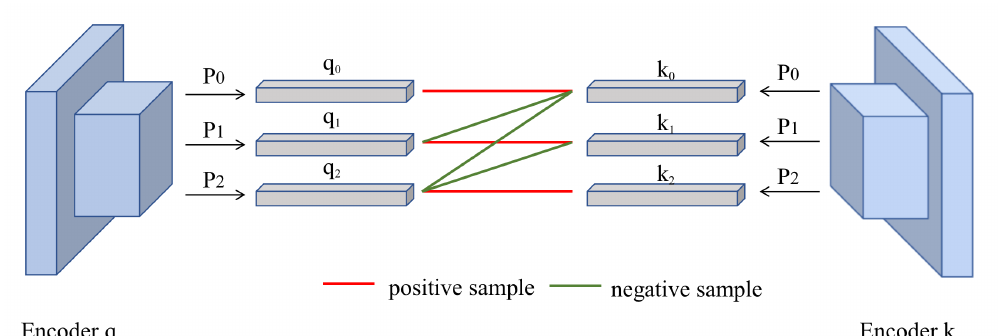
Figure 3. Positive and negative sample construction method in the multi-layer.